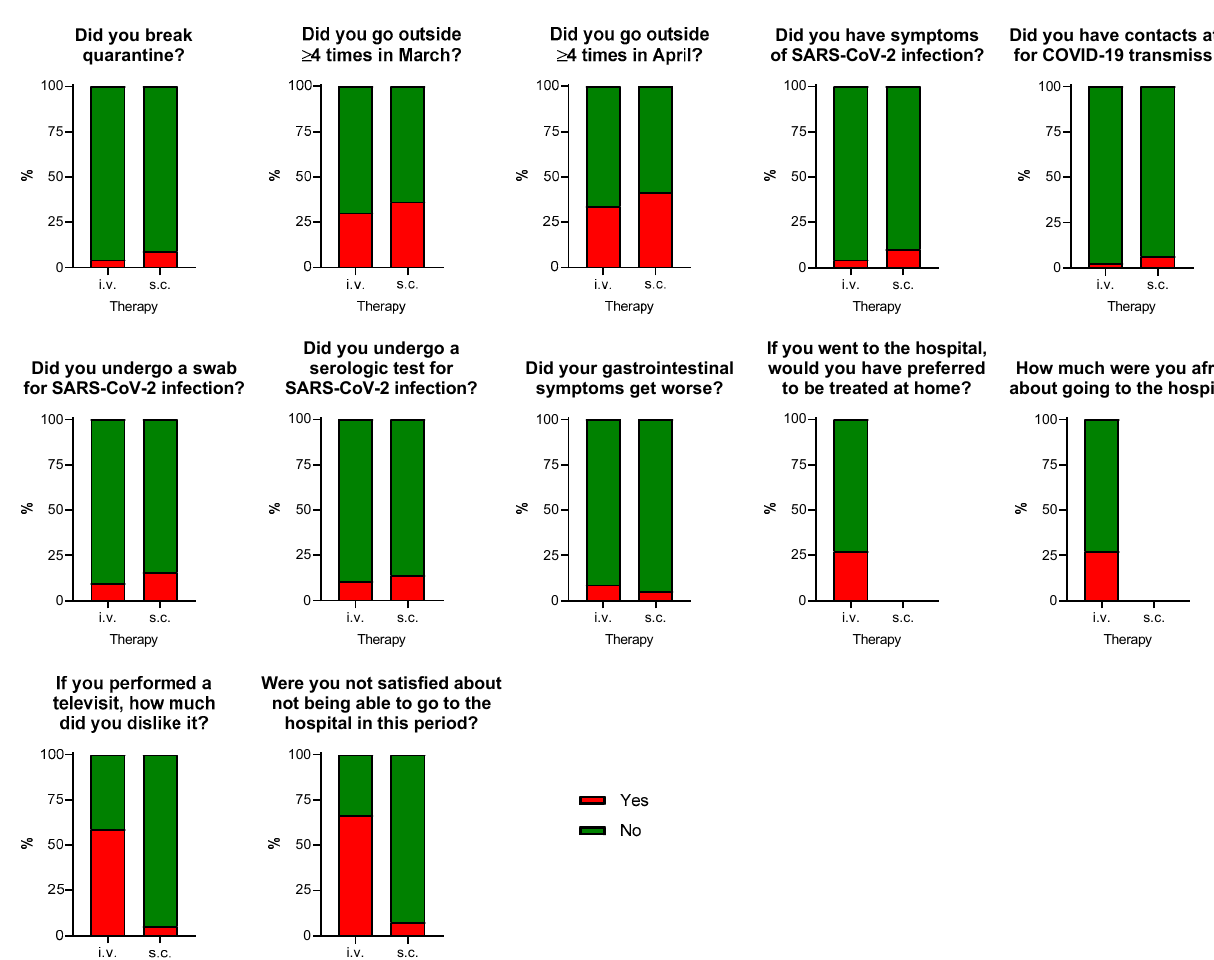
Figure 3. Responses to COVID-related additional questions in IBD patients treated with i.v. or s.c. biological therapy. A positive response indicates a score > 5 for the questions “How much were you afraid about going to the hospital?” and “If you performed a televisit, how much did you dislike it?”.